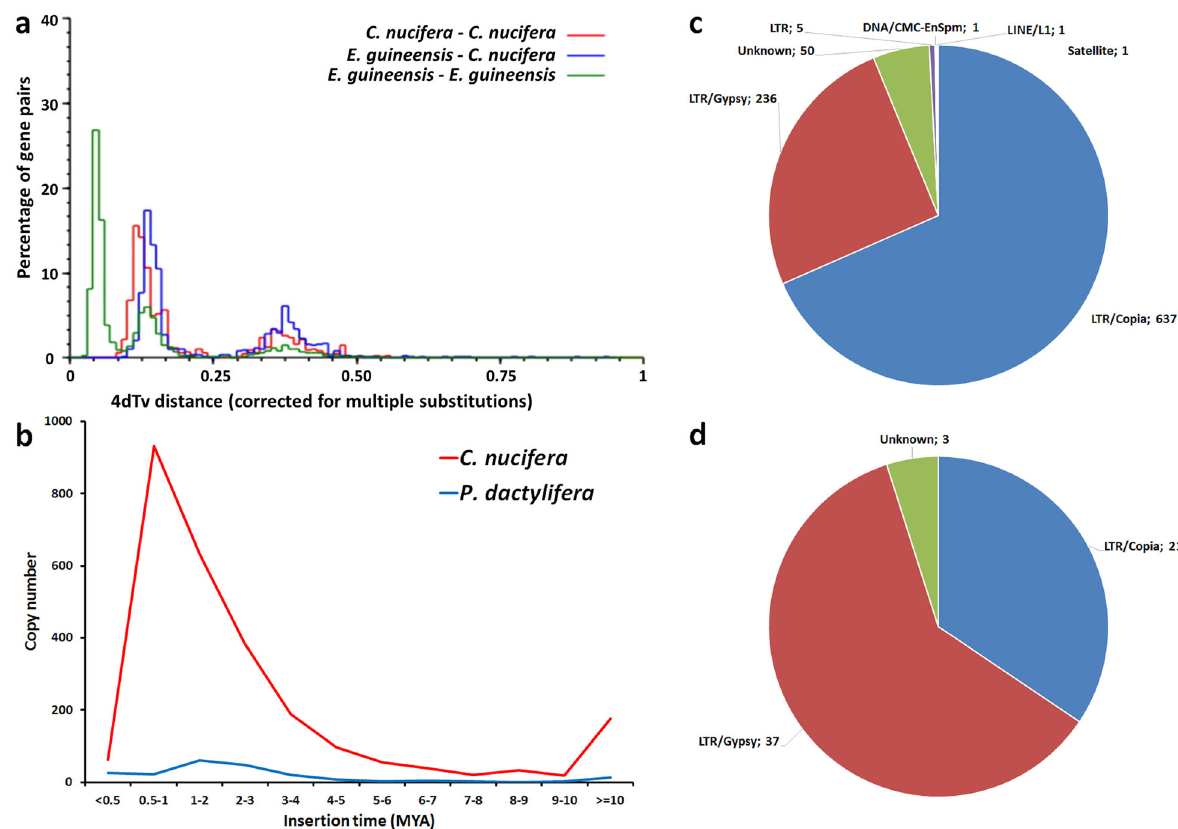
Fig. 3 Comparison between the genomes of coconut and of related species. a Distribution of 4DTV distances between homologs in coconut, in oil palm, and between these species. b Distribution of copy numbers of LTR over the insertion time in coconut and date palm, showing a peak in coconut in the last MYA. c LTRs composition at peak insertion time for coconut. and LTRs composition at peak insertion time. d Same as ( c ) for date